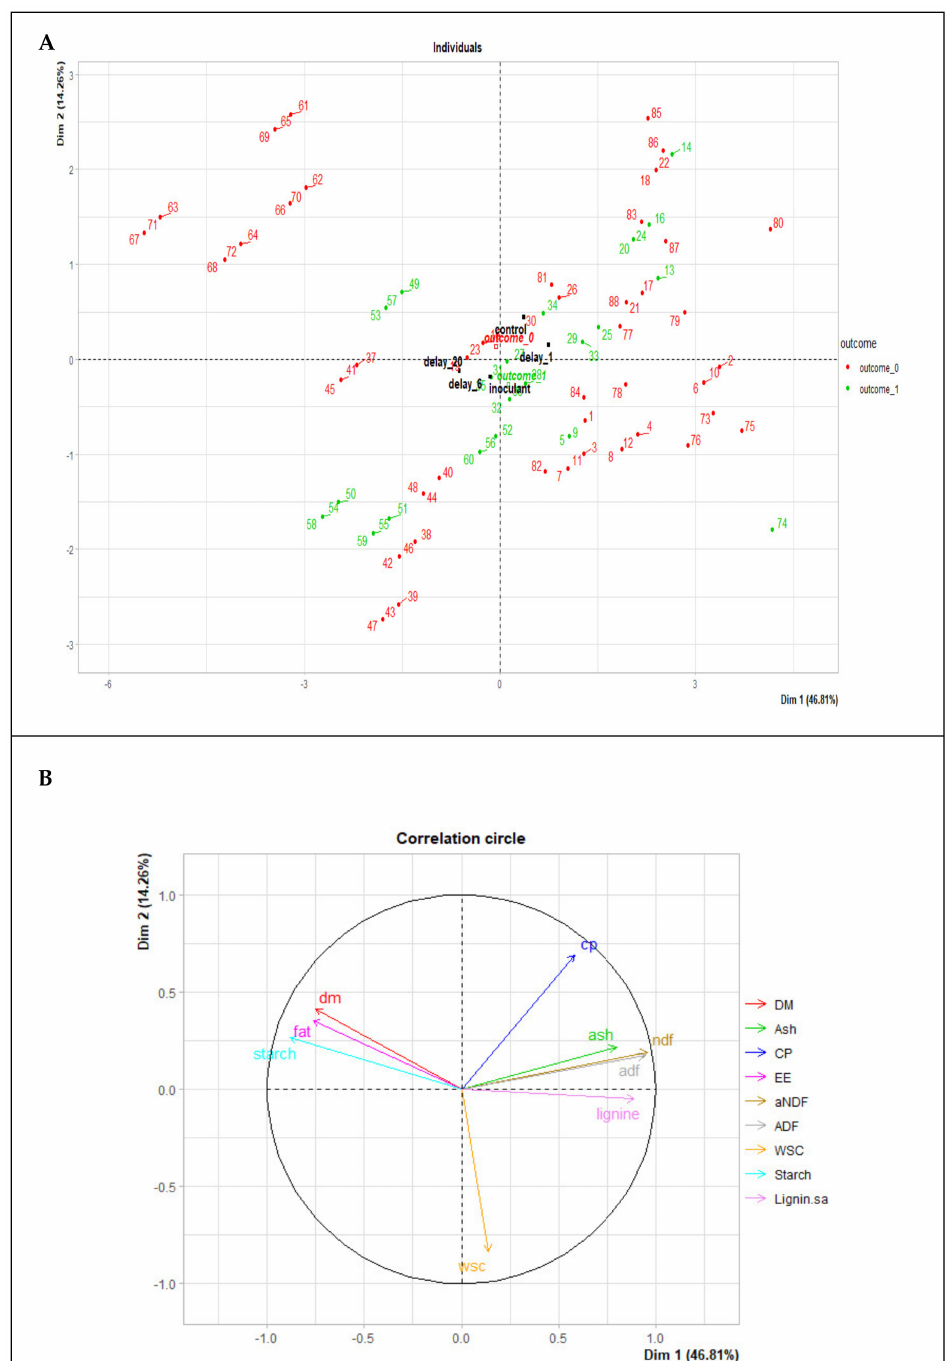
Figure 2. The first two Multi Factorial Dimensions (Dim1 and Dim 2) graphs explain the 46.8 and 14.3% of the total variability. ( A ), the plots of the coordinates of the samples coloured according to the event of aerobic instability (outcome = 1, green) or aerobic stability (outcome = 0, red), and the plot of the qualitative variables coordinates: the delay in silage sealing, (1, 6, or 20 h), and the use of inoculant (inoculant or control). ( B ) the correlation circle (correlation = 1) shows the relationship between variables and the dimensions (Dim-1 and Dim-2). Variable points away from the origin are well represented on the factor